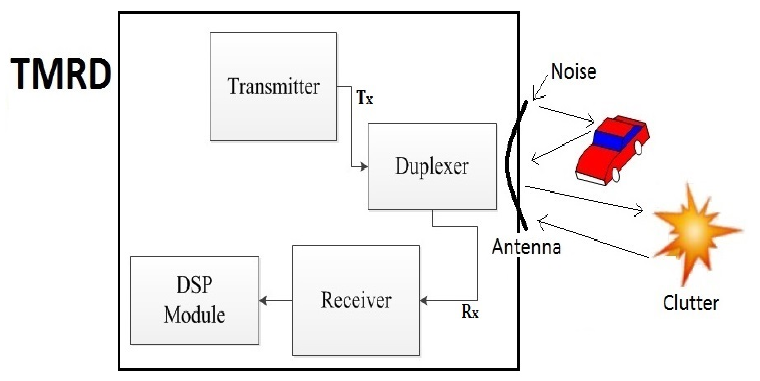
Figure 1. Functional structure of the frequency-modulated continuous waveform (FMCW) traffic microwave radar detector (TMRD) system.